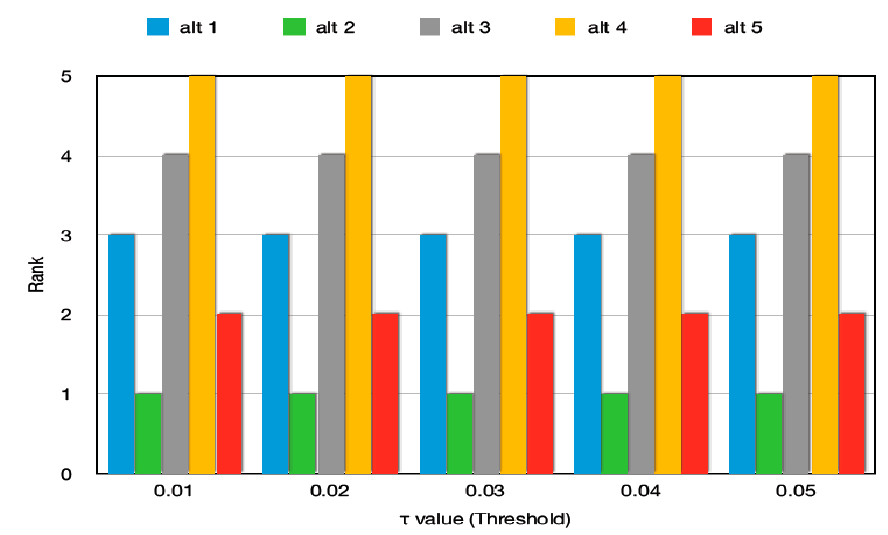
Figure 6. Ranking results produced for various τ values based on sensitivity analysis.